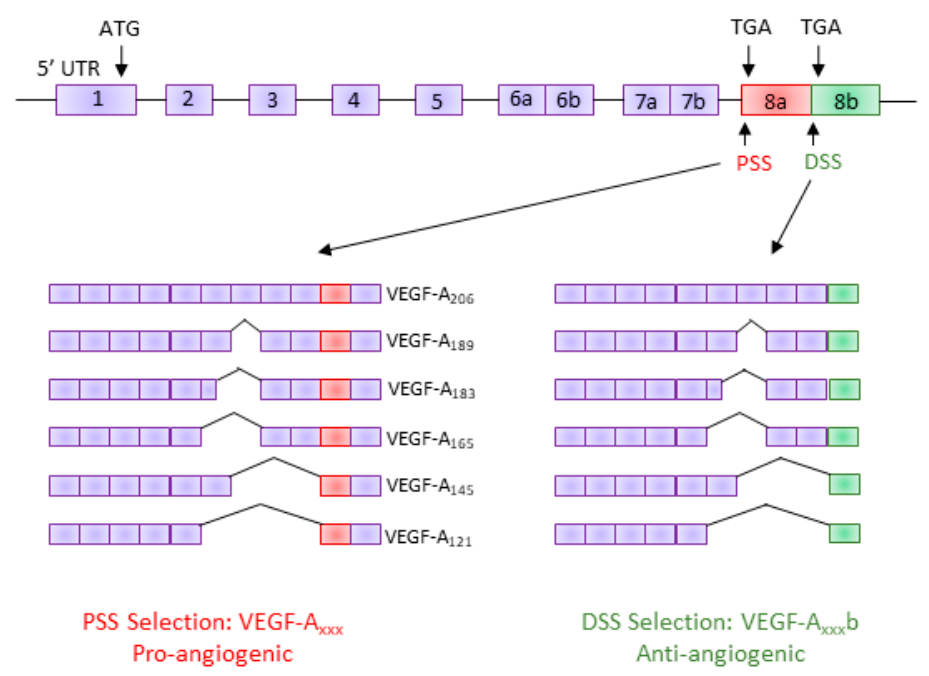
Figure 1. Vascular endothelial growth factor A (VEGF-A) splice variants. The VEGF-A pre-mRNA is comprised of eight exons; inclusion/exclusion of these exons gives rise to several isoforms with differing amino acid lengths. In the terminal exon (exon 8), an alternative 3 ′ splice site results in a new family of isoforms, the VEGF-A xxx b family. These isoforms have the same number of amino acids but a different C-terminus sequence, resulting in them being functionally different (anti-angiogenic). PSS: proximal splice site; DSS: distal splice site; UTR: untranslated region.